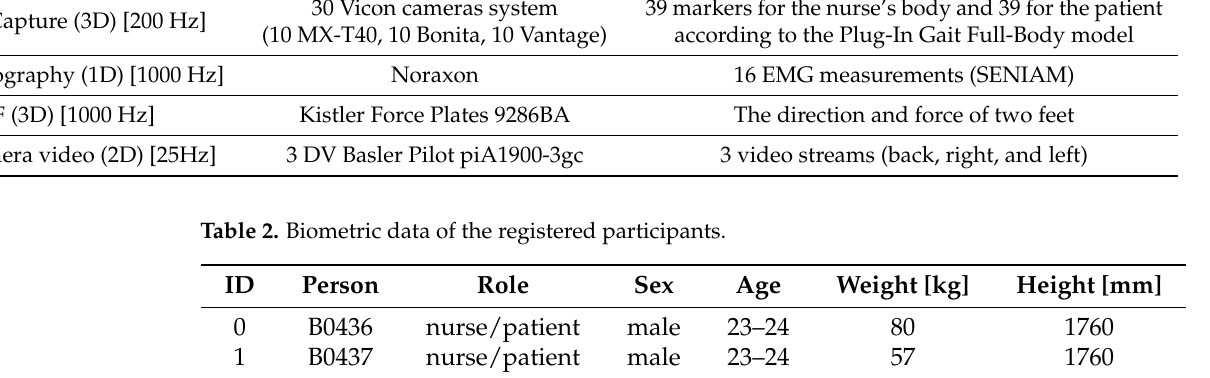
Table 1. Configuration of the custom prepared environment for multimodal data acquisition of patient lifting. Data Type